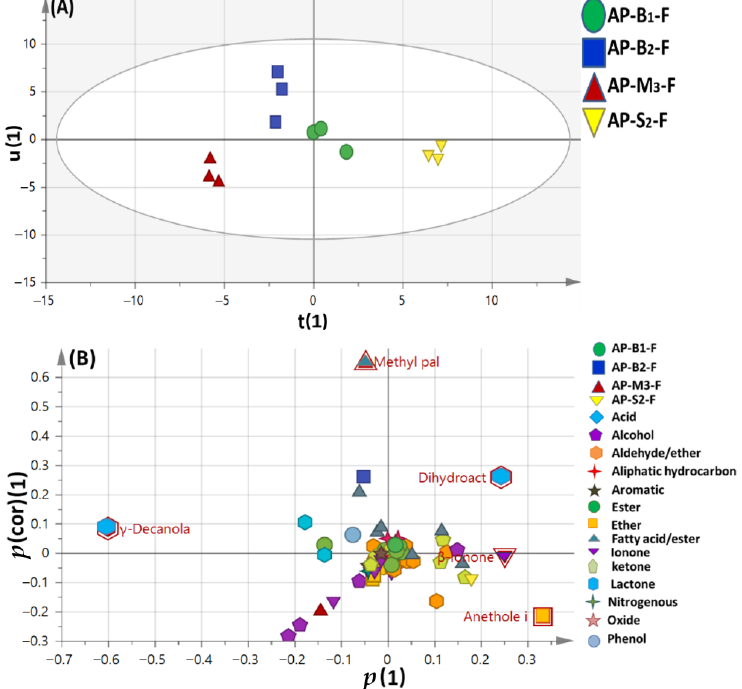
Figure 5. GC – MS-based OPLS-DA score plot ( A ) derived from modeling volatile metabolites of different apricot fruit cultivars ( n = 3). The respective loading plots ( B ) showing the covariance p (1) against the correlation p (cor) (1) of the variables of the discriminating component of the OPLS-DA